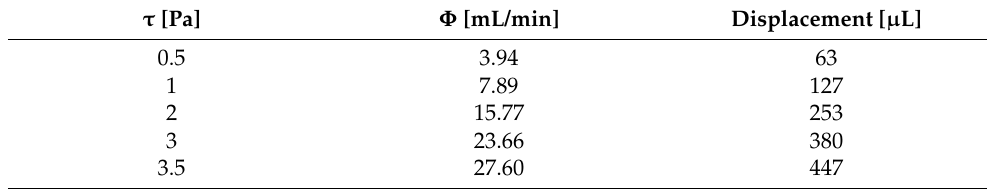
Table 1. Shear Stress table for µ -Slide VI 0.4 for viscosity η = 0.0072 dynes/cm 2 = 0.00072